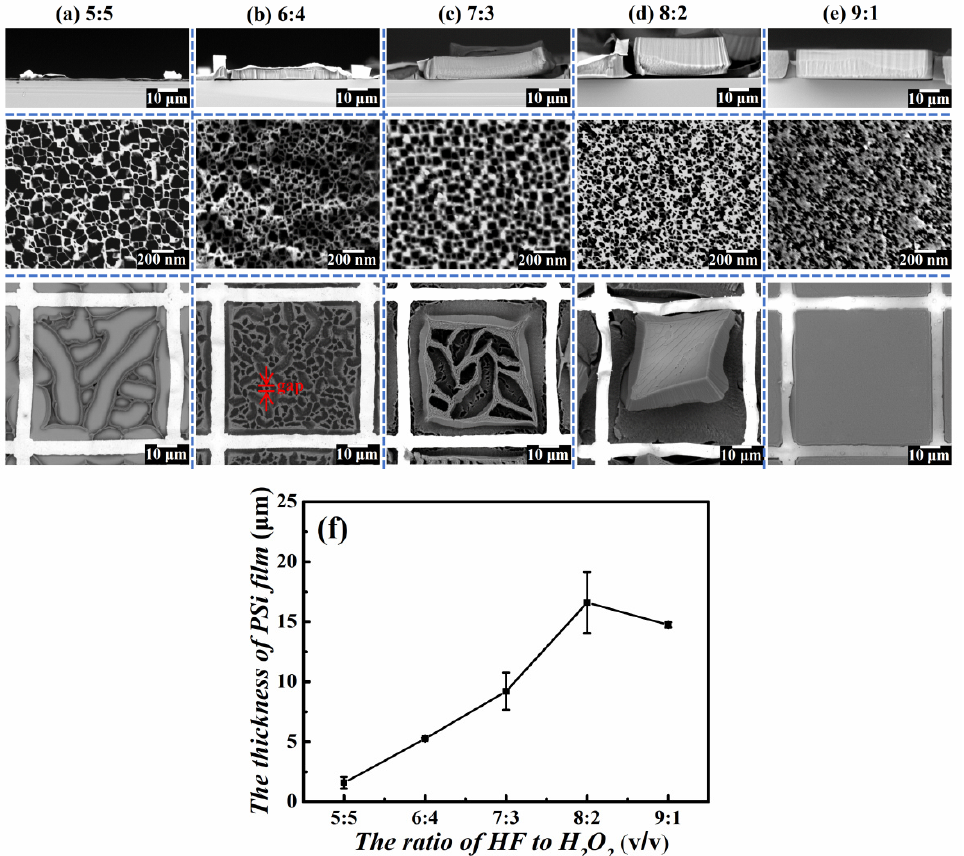
Figure 2. SEM images (top: cross-sectional view, middle: high resolution of top view, bottom: top view) of a patterned Si etched in different R ( a ) 5:5, ( b ) 6:4, ( c ) 7:3, ( d ) 8:2, and ( e ) 9:1 for 30 min, respectively. ( f ) The thickness of PSi film as a function of the R .